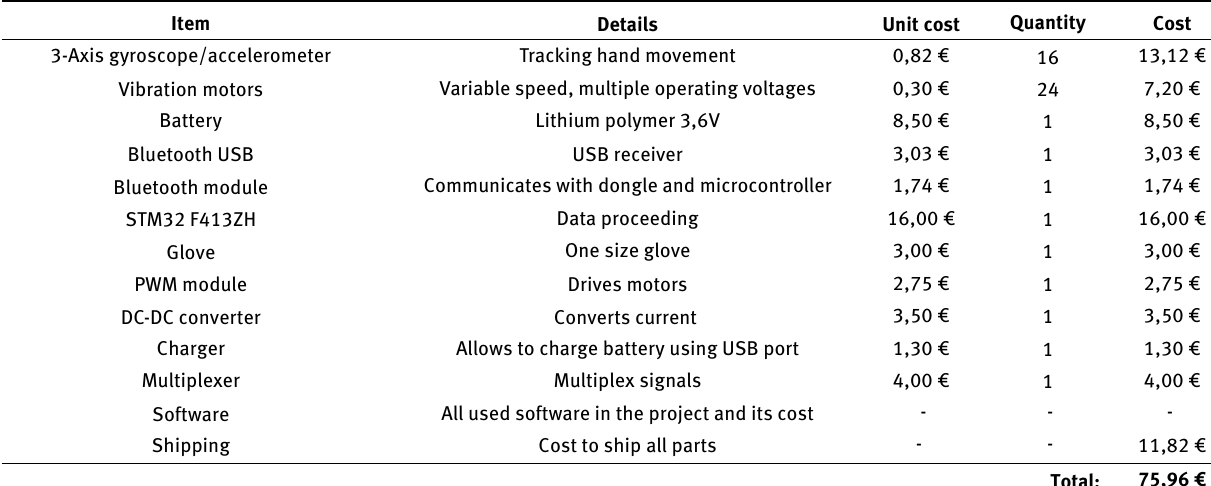
Table 1: Cost analysis.